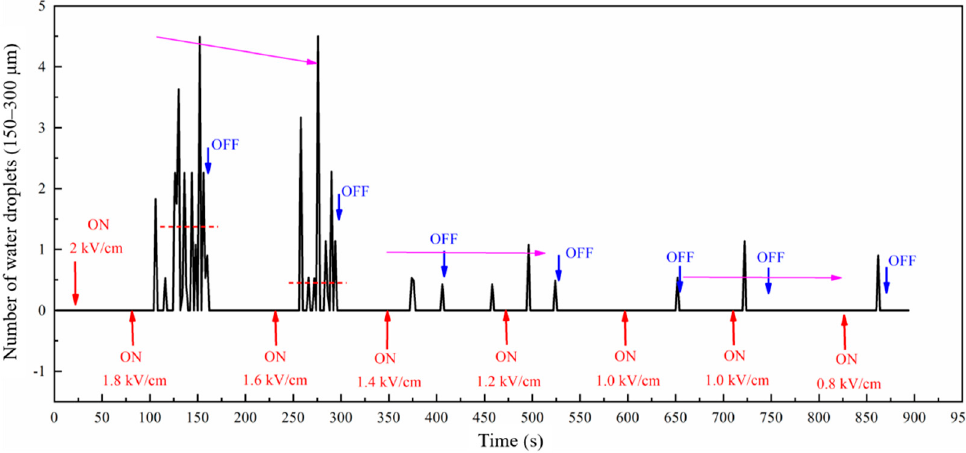
Figure 11. Variations of water droplet number within 150 to 300 μ m.